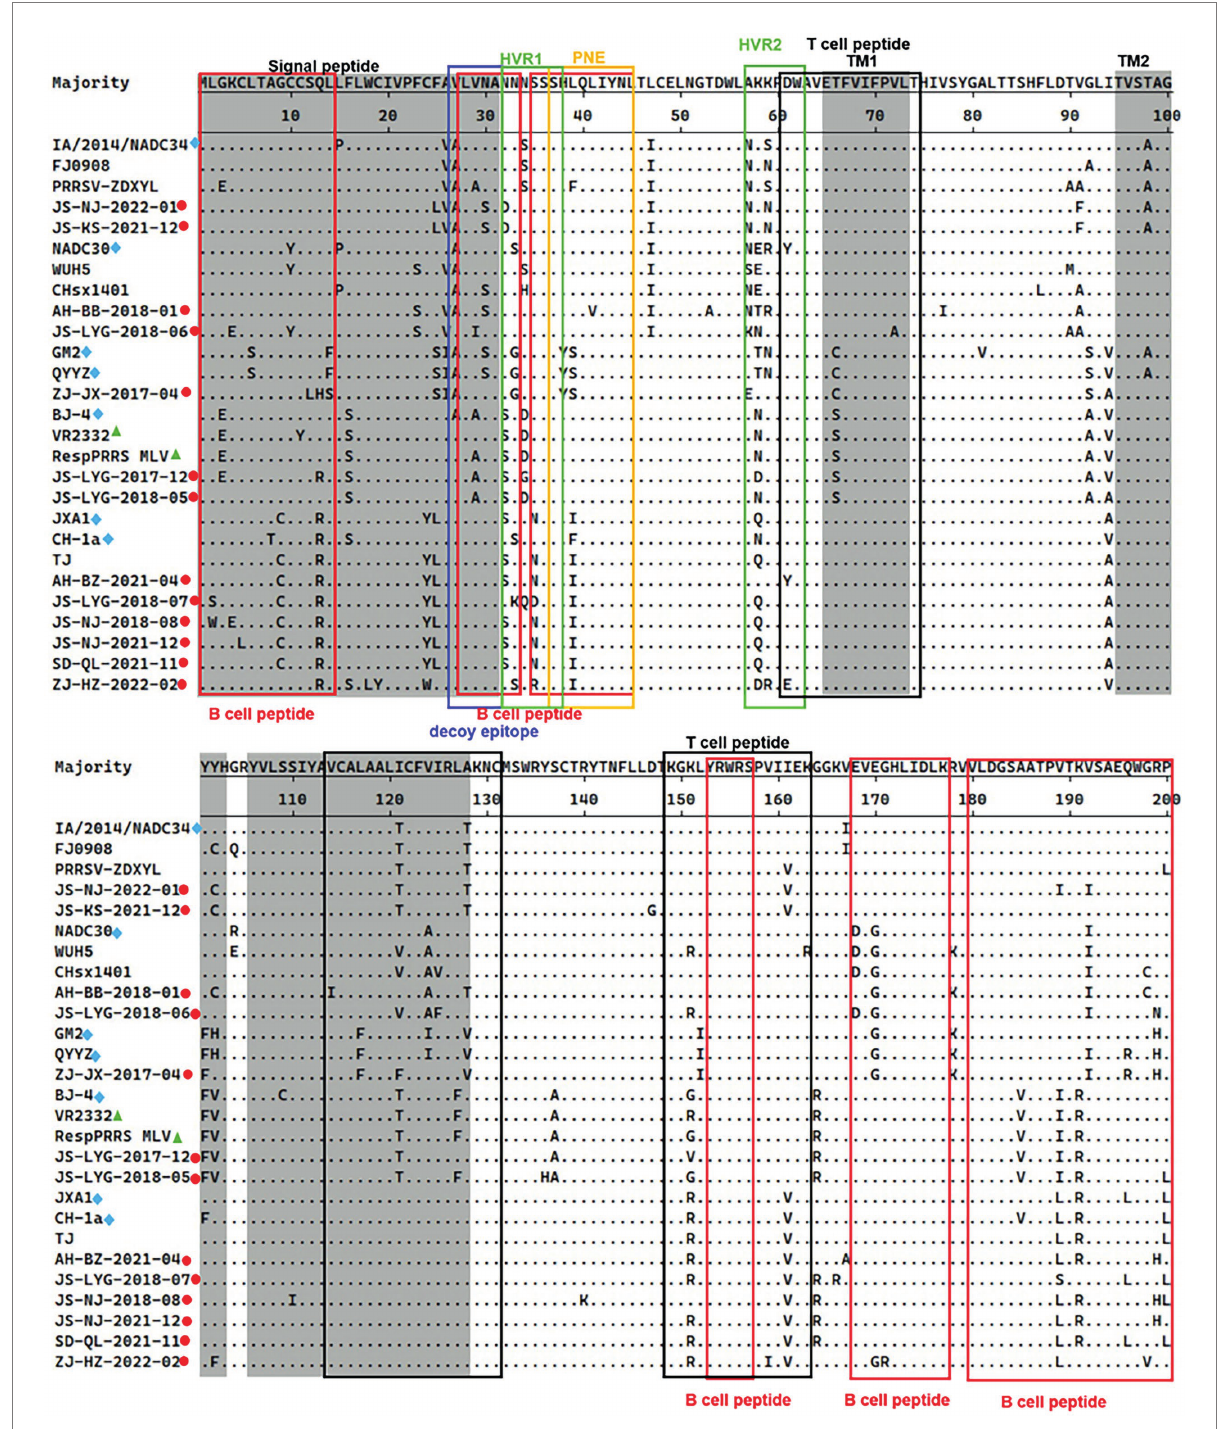
FIGURE 3 Alignment of full-length GP5 amino acid sequences of 13 positive PRRSV strains and 14 reference PRRSV strains. The represent PRRSV strains are indicated with blue diamonds, the new PRRSV isolates identified are labeled with red circles and PRRSV vaccine strains are indicated with green triangles. The grey areas represent signal peptide and transmembrane regions (TM). Red boxes indicated B-cell epitopes and black boxes indicated T-cell epitopes. Primary neutralizing epitope (PNE) was shown in blue box and the decoy epitope was shown in yellow box. Hypervariable regions (HVR) were shown in green